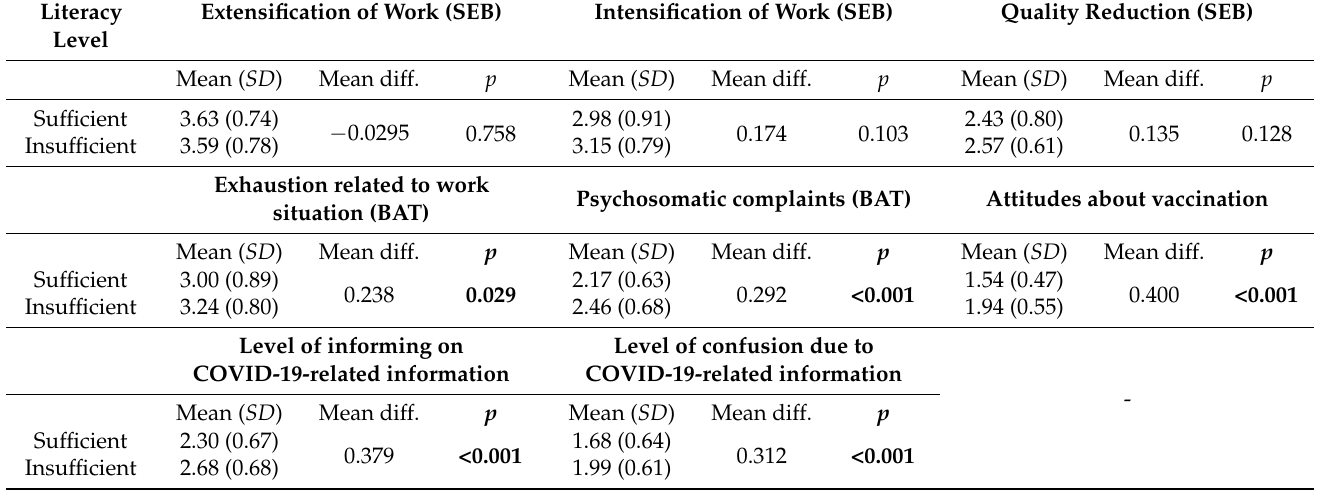
Table 3. Score difference in self-endangering behaviours, secondary symptoms of burnout and attitude about vaccination based on the health literacy levels using independent t